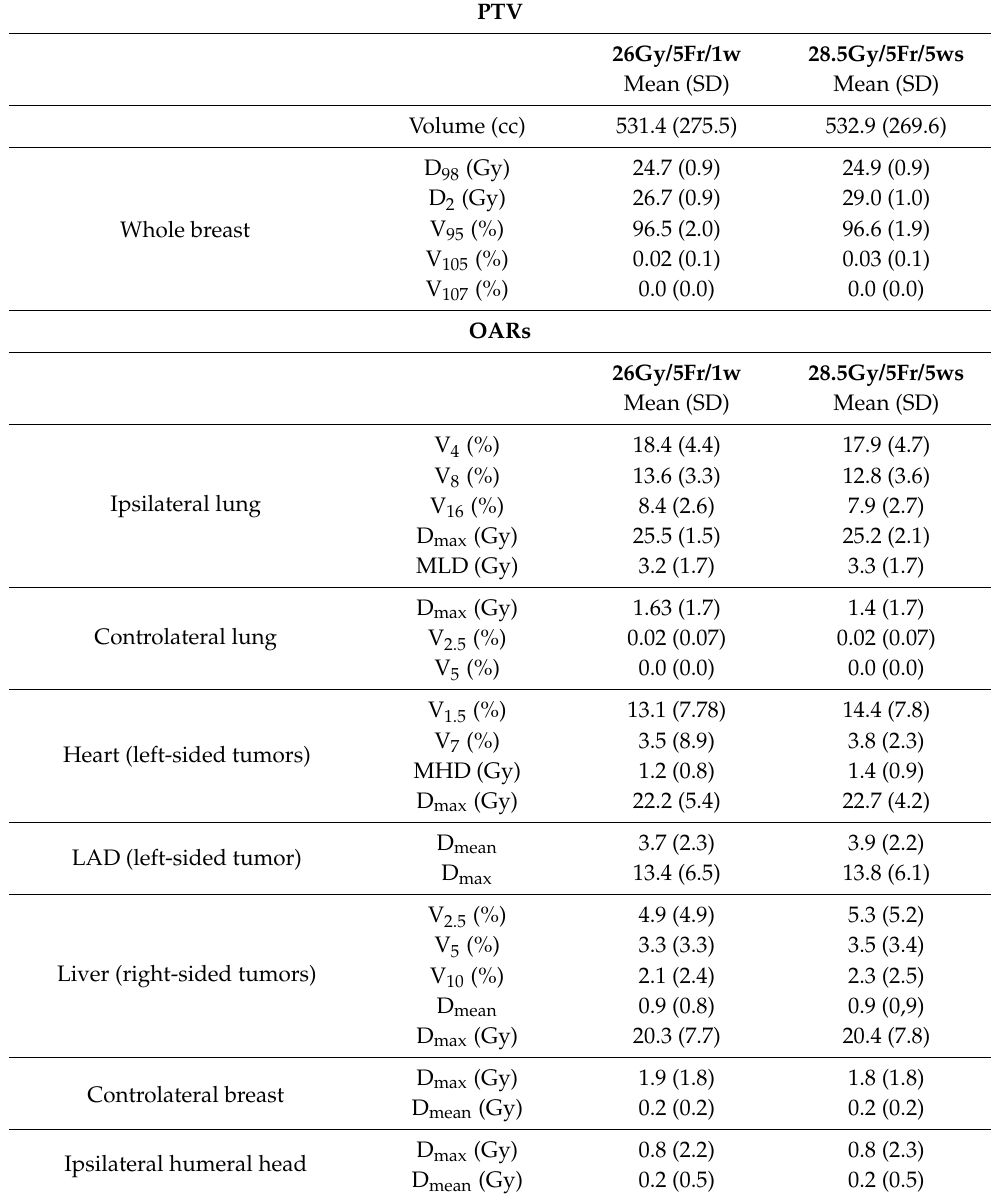
Table 4. Dosimetric